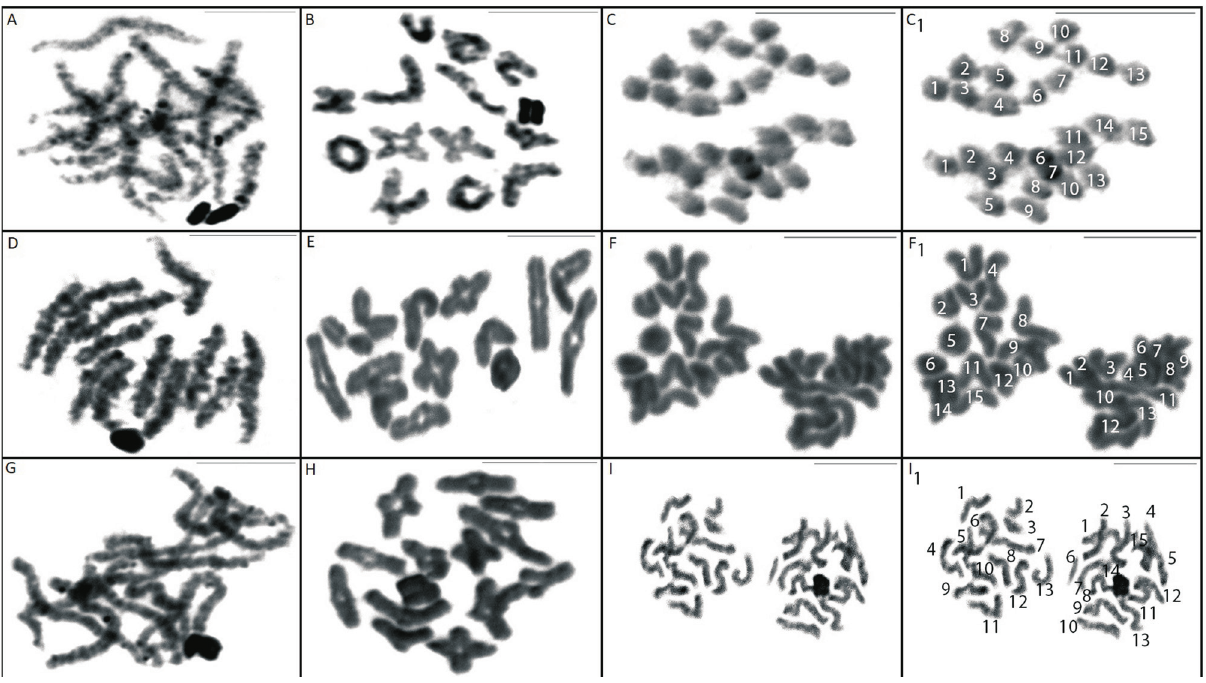
Figure 3 - Meiotic cells in pachytene (A, D, G), diplotene (B, E, H) and metaphase II (C, F, I) of: Ctenus amphora . (A, B, C); C. crulsi . (D, E, F); C. villasboasi (G, H, I). Metaphase II cells shows the division of chromosome between cells poles, with n = 13 and n = 15 (13+X 1 X 2 ) during segregation. Scale= 10 (cid:2)